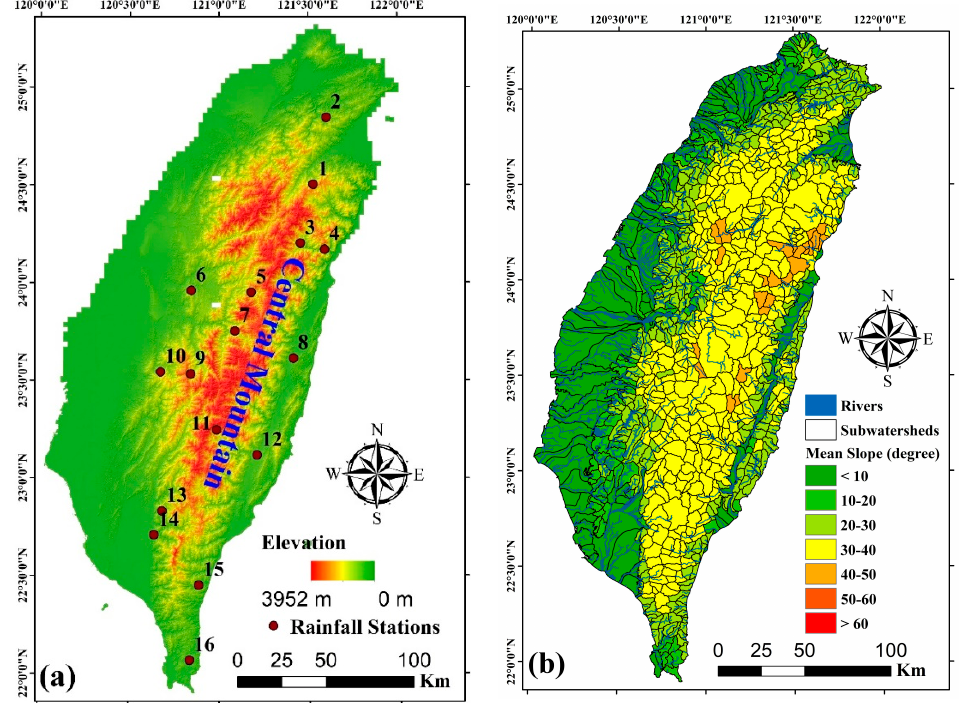
Figure 1. Distribution of elevation, rainfall stations ( a ), slope, rivers, and sub-watersheds ( b ) in Tai- wan.